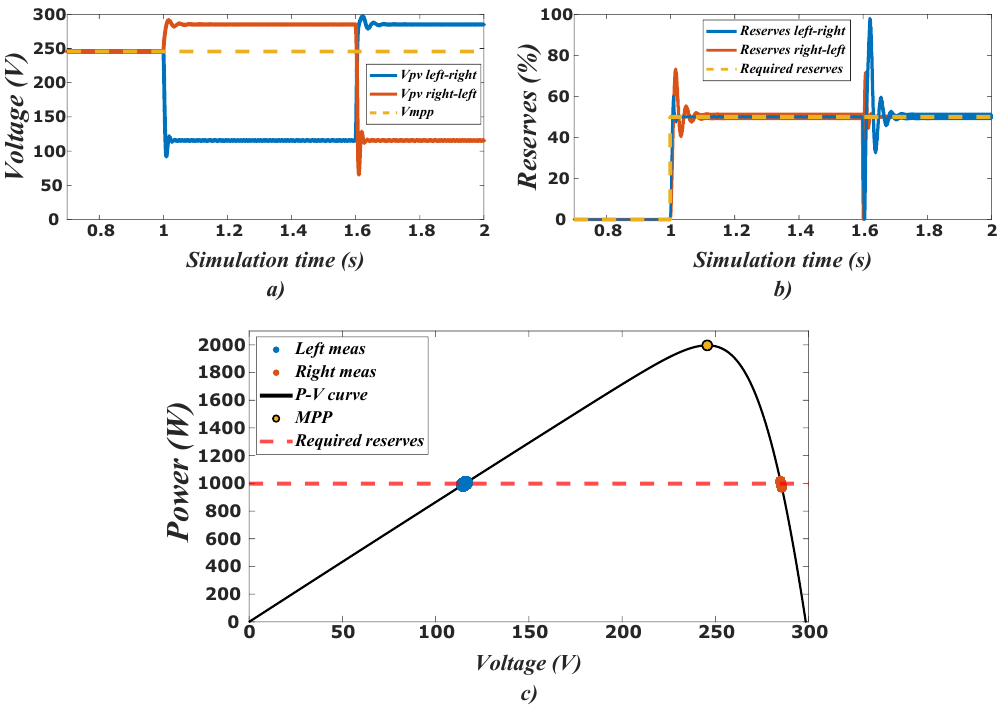
Figure 14. Case Study #1: ( a ) Voltage evolution, ( b ) Power reserves evolution and ( c ) Actual P - V curve, measurement windows and requested reserves at t = 1.5